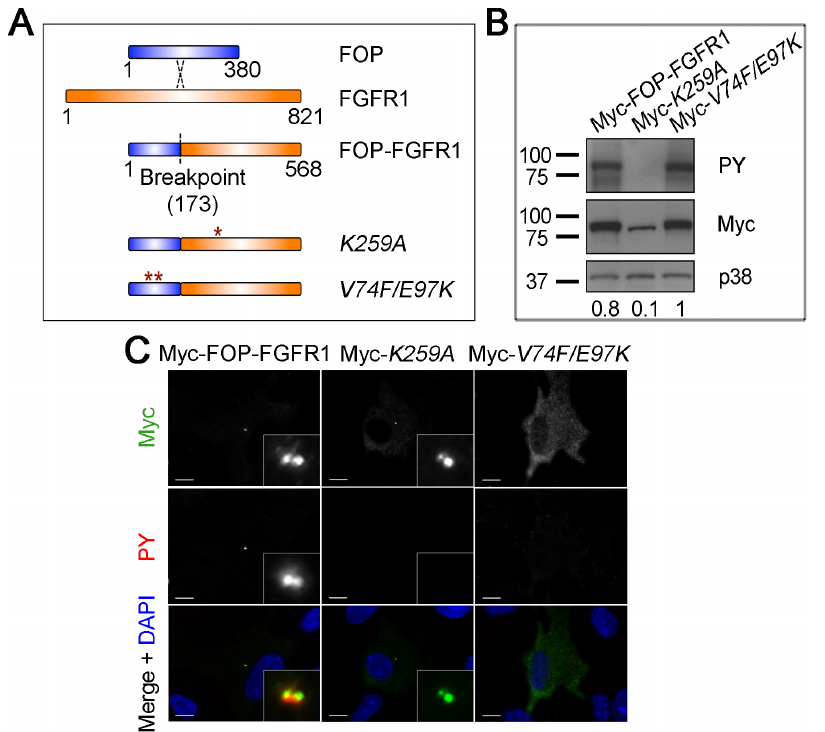
Figure 1. FOP-FGFR1 V74F/E97K mutant lacks centrosome localization but not kinase activity. ( A ) Schematic of fusion between FOP and FGFR1 resulting in the FOP-FGFR1 oncogenic fusion and subsequent point mutations to produce KD, FOP-FGFR1 K259A , and centrosome localization mutant, FOP-FGFR1 V74F/E97K . ( B ) WB analysis of lysates from RPE-1 cells transfected with WT Myc-FOP-FGFR1, Myc-FOP-FGFR1 K259A , or Myc-FOP- FGFR1 V74F/E97K , harvested, and probed with antibodies against phosphotyrosine (PY), Myc, and p38 as a loading control. ( C ) RPE-1 cells transfected with Myc-FOP-FGFR1, Myc-FOP-FGFR1 K259A , or Myc-FOP-FGFR1 V74F/E97K , fixed, and stained with antibodies against Myc (green) and PY (red). DNA is stained using DAPI (blue). Scale bars: 10 m m; insets: 10 6